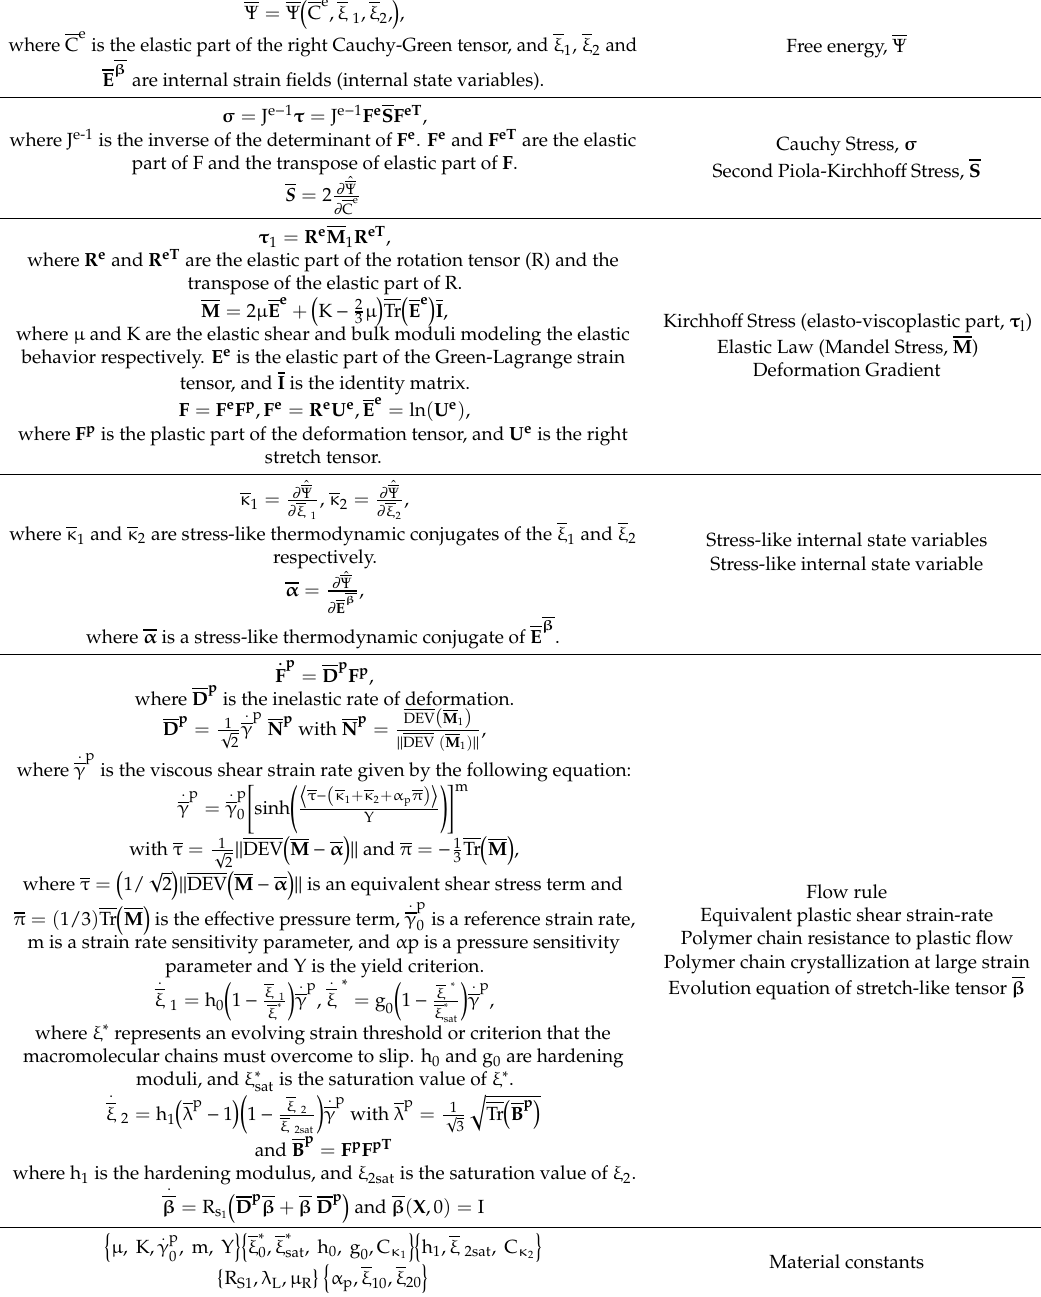
Table 3. Summary of the model equations for MSU TP 1.1 (see Bouvard et al. [40]). See Appendix C for a summary of symbol